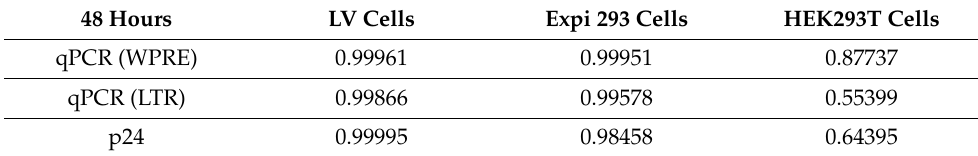
Table 1. Correlation between qPCR and p24 results for the constructs and %GFP-containing infected